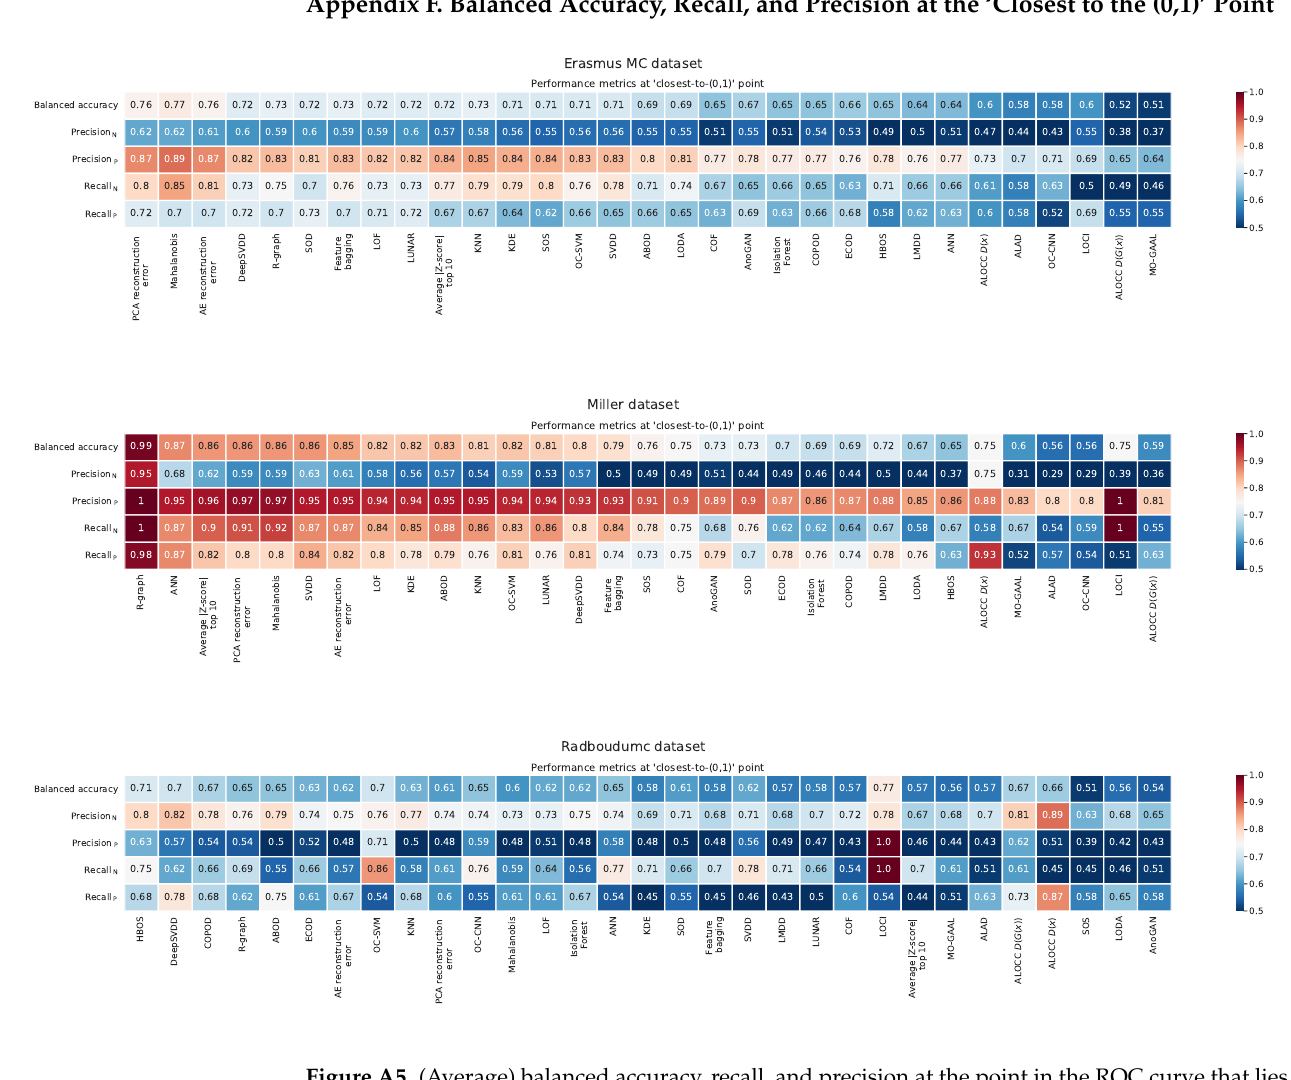
Figure A5. (Average) balanced accuracy, recall, and precision at the point in the ROC curve that lies closest to the (0,1) point. Methods are ordered by descending average AUC per dataset. All reported values are the average across all (test)